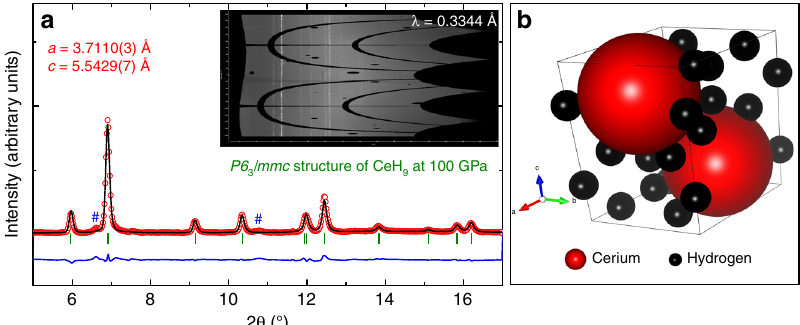
Fig. 2 XRD pattern and the result of Rietveld re fi nement for the hexagonal CeH 9 in P6 3 /mmc structure. a Rietveld re fi nement plot of powder XRD data at 100 GPa. Red open circles: experimental data of CeH 9 in P6 3 /mmc structure at 100 GPa; black line: simulated XRD based on the structural model; green vertical lines: Bragg diffraction positions of the structure; blue line: the difference between the simulated and the original XRD. Reliability parameters for the Rietveld re fi nement are as follows (in %): R p = 14.5, R wp = 18.4, R Bragg = 8.05. Blue hash symbols represent unidenti fi ed weak peaks. Inset shows the Pilatus XRD image of corresponding powder XRD pattern with the incident X-ray wavelength of 0.3344 Å. b Crystal structure model of P6 3 /mmc structured CeH 9 . Red and black spheres represent cerium and hydrogen atoms, respectively